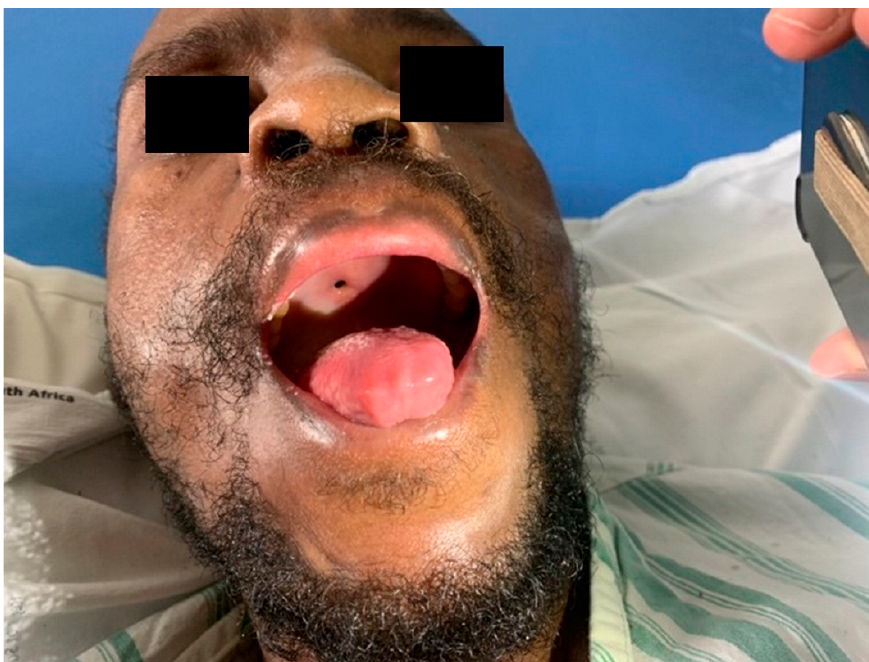
Figure 9. 2 mm diameter fistula in hard palate.